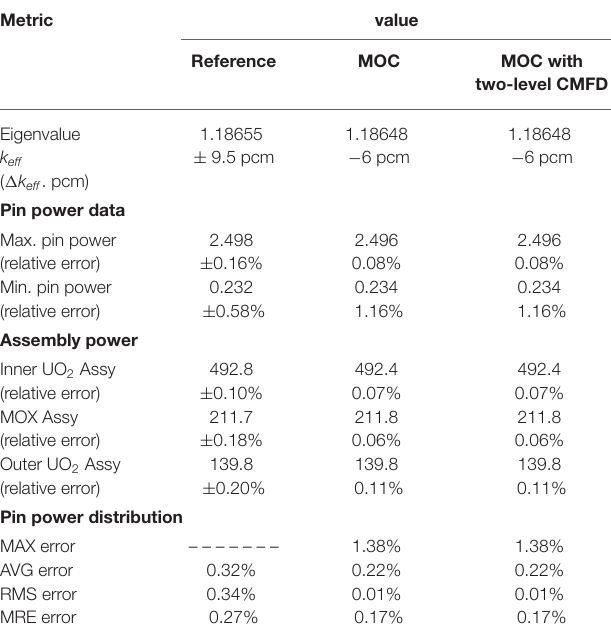
TABLE 1 | Runtime, Eigenvalue, and Power Distribution Results for 2-D C5G7 Benchmark. Metric